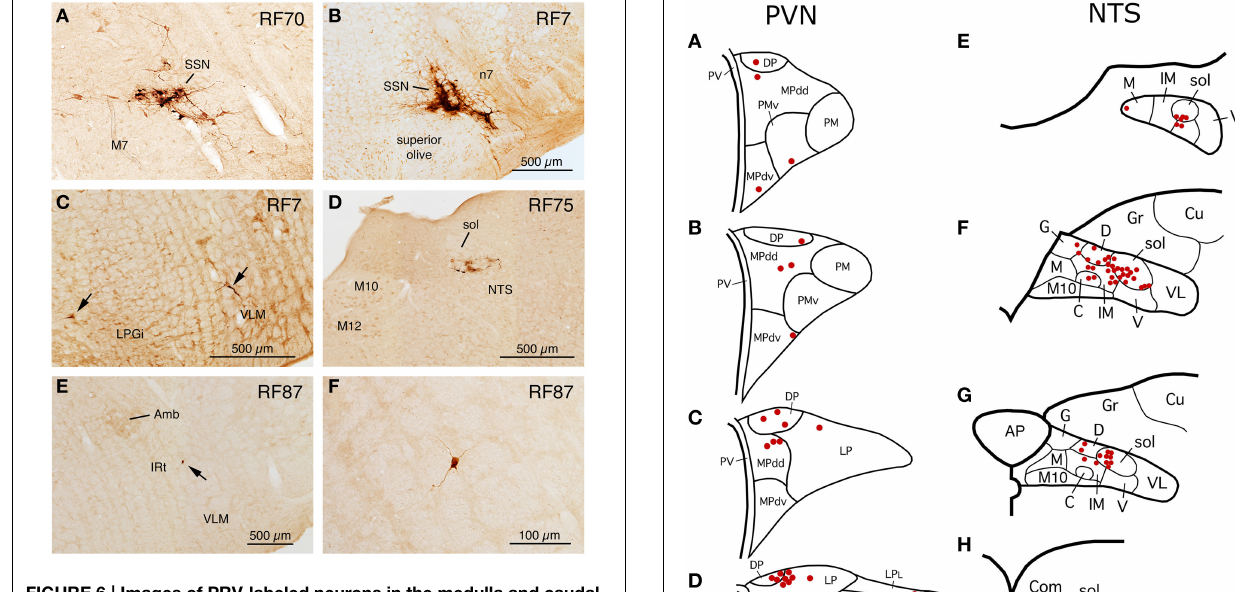
FIGURE 6 | Images of PRV-labeled neurons in the medulla and caudal pons after an intrachoroidal injection of virus into the right eye, with the labeled neurons detected by PAP immunolabeling with DAB. (A,B) Show low-power views of PRV + neurons in the right superior salivatory nucleus (SSN) of RF70 (74h survival) and RF7 (52h survival). (C) Shows PRV + neurons in the right rostral ventrolateral medulla (RVLM) in RF7. (D) Shows PRV + neurons in the right NTS of RF75 (142.4h survival after minute intrachoroidal PRV injection). (E,F) Show low and high power views of a labeled neuron in the right intermediate reticular nucleus (IRt) of RF87 (73.5h survival). Arrows indicate PRV + neurons (C,E) . The scale bar in (B) provides the magnification for (A,B) . All images are of coronal sections.